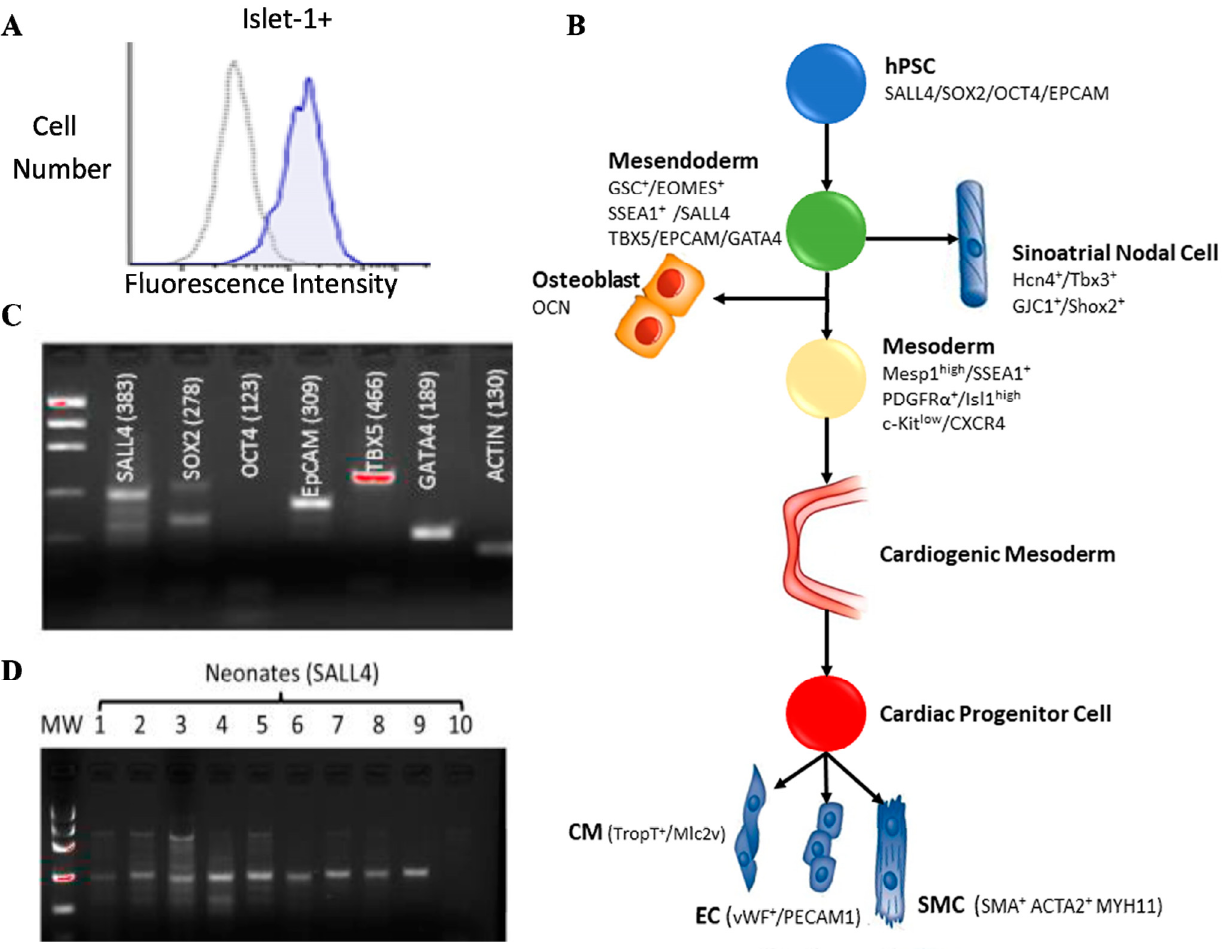
Figure 1. Isl-1+ neonatal CPCs express early-stage transcripts. Flow cytometry confirmed expression of Isl-1 in human neonatal CPC clones ( A ). Stemness associated transcripts appear early in cardio- vascular development ( B ). PCR products were run on an agarose gel, transcripts for SALL4, SOX2, EpCAM, and TBX5 were co-expressed on a representative Isl-1+ neonatal CPC clone ( C ). PCR prod- ucts were run on an agarose gel showing SALL4 expression in nine out of ten Isl-1+ neonatal CPC clones ( D